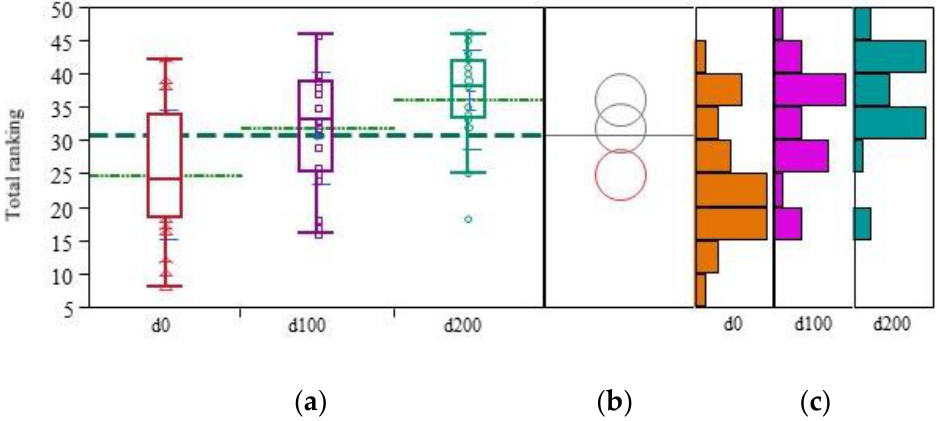
Figure 1. Overall enhancement of the clinical and psychological status. Boxplot diagrams at different treatment periods ( a ), Dunnett’s test against the control at d0 (red circle) ( b ), and distribution histograms of changes during the treatment ( c ) of the overall enhancement of the clinical and psychological status of the patients with autism during the methylcobalamin supplementation (d0—before the treatment, d100—at day 100, d200—at day 200 of the treatment). Table 1. Total and partial ranking values (Rv) of the clinical and psychological assessments during the study (d0—before the treatment, d100—at day 100 of treatment, d200—at day 200 of treatment) and evaluation of the overall absolute and relative change (d200 vs. d0 values) explained by Cohen delta, and normalized gain of the treatment.